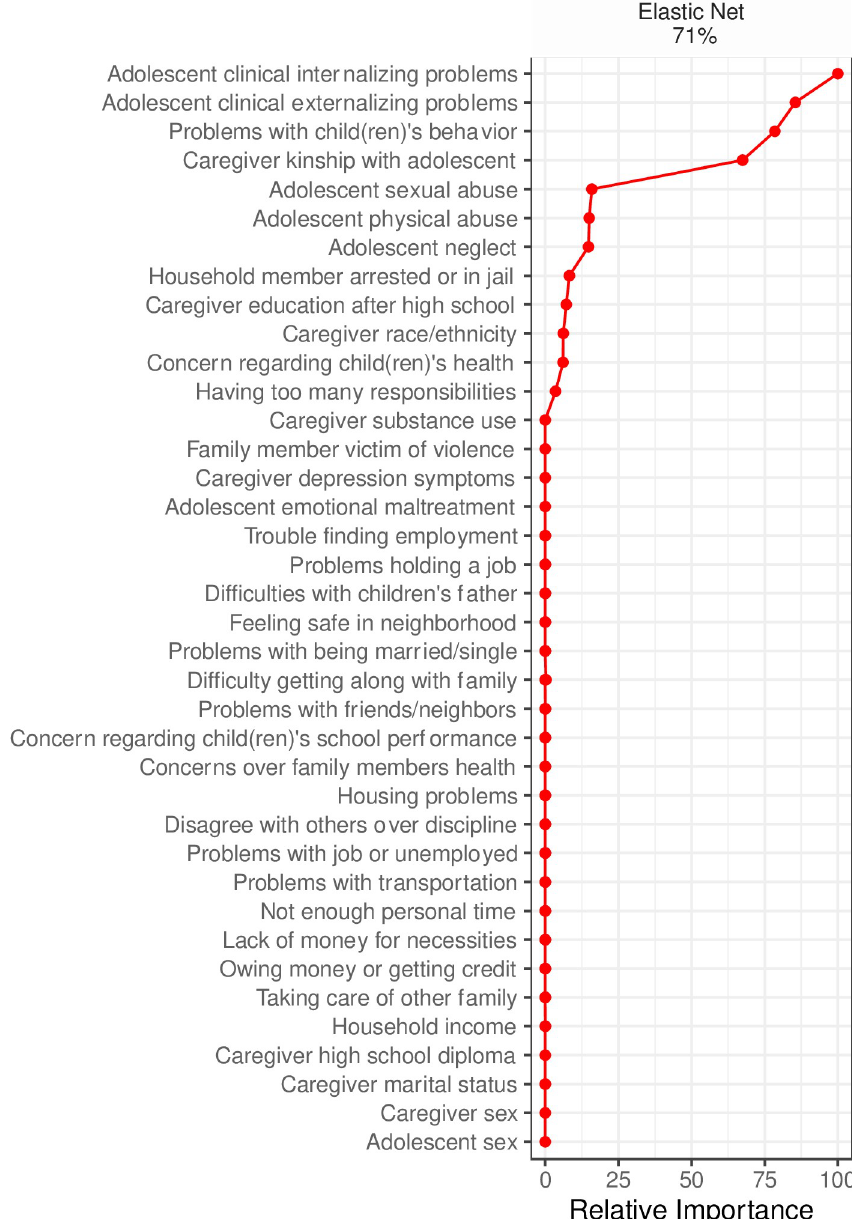
Fig 2. Relative importance of predictors of caregiver utilization of adolescent counseling services. Predictors that were reduced to zero are not ranked in order of importance. % represents balanced classification accuracy.